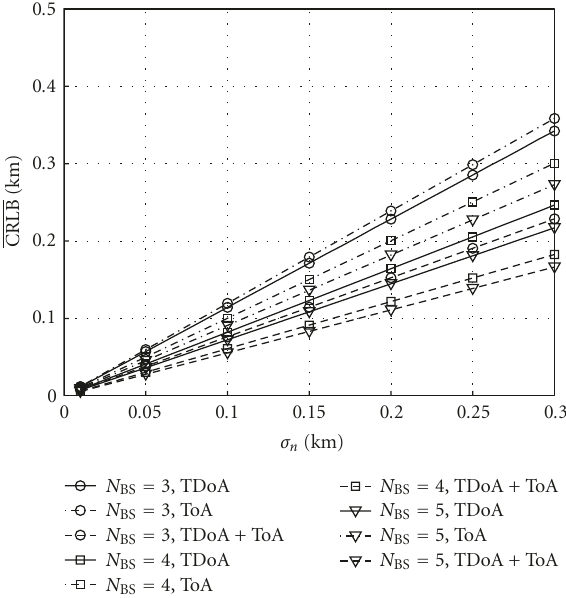
Figure 2: CRLB versus σ n for di ff erent positioning methods, R = 3